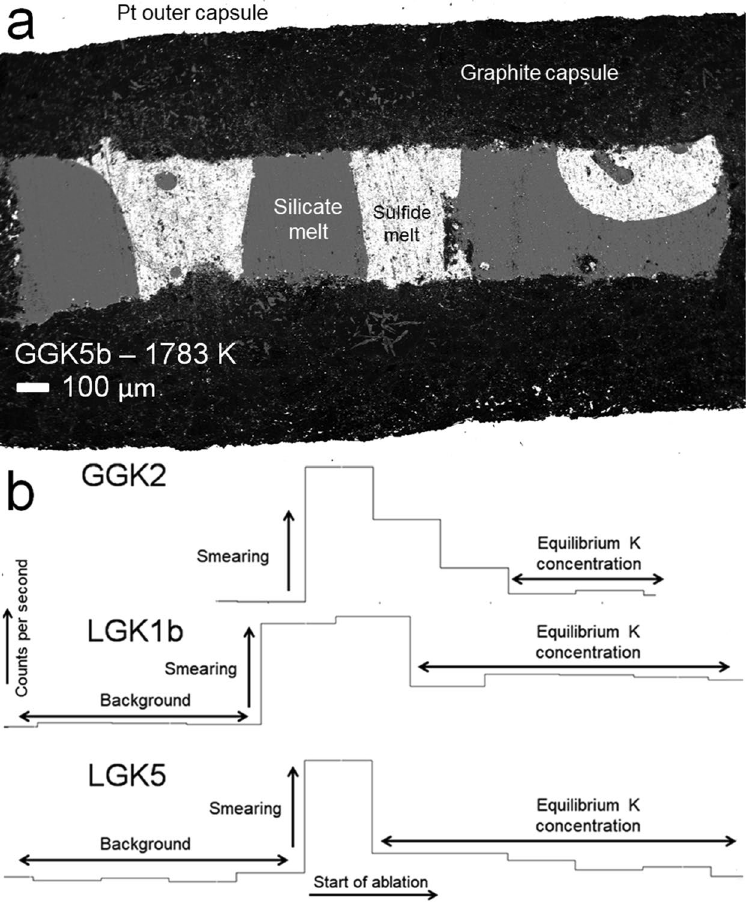
Figure 1. ( a ) Backscattered electron image of typical run product (experiment GGK5b performed at 1783 K, Table 1) ( b ) Example LA-ICP-MS GLITTER ® profiles for K in selected sulfides and metals. High signal intensities in the initial ablation reflect the much higher abundances of K on the sulfide or metal surface in some runs due to smearing. The stable plateau after this initial peak reflects the actual concentration of K in the sulfide or metal phase, which is far lower than the initial